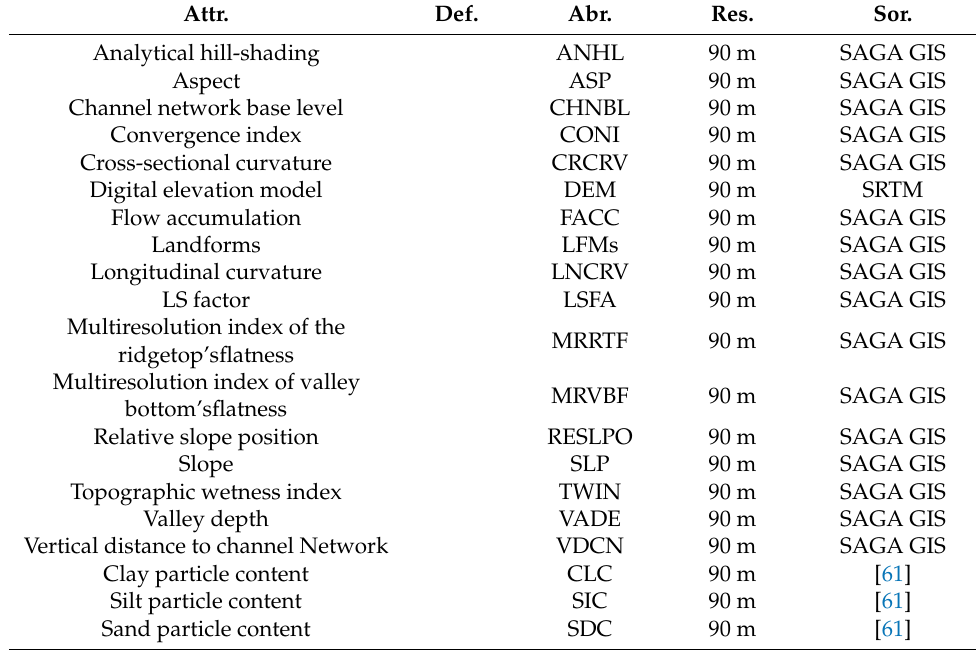
Table 2. Covariates used to develop soil texture class ANN prediction model. Attr. Def. Abr. Res. Sor. Analytical hill-shading ANHL 90 m SAGA GIS Aspect ASP 90 m SAGA GIS Channel network base level CHNBL 90 m SAGA GIS Convergence index CONI 90 m SAGA GIS Cross-sectional curvature CRCRV 90 m SAGA GIS Digital elevation model DEM 90 m SRTM Flow accumulation FACC 90 m SAGA GIS Landforms LFMs 90 m SAGA GIS Longitudinal curvature LNCRV 90 m SAGA GIS LS factor LSFA 90 m SAGA GIS Multiresolution index of the MRRTF 90 m SAGA GIS ridgetop’sflatness MRVBF bottom’sflatness